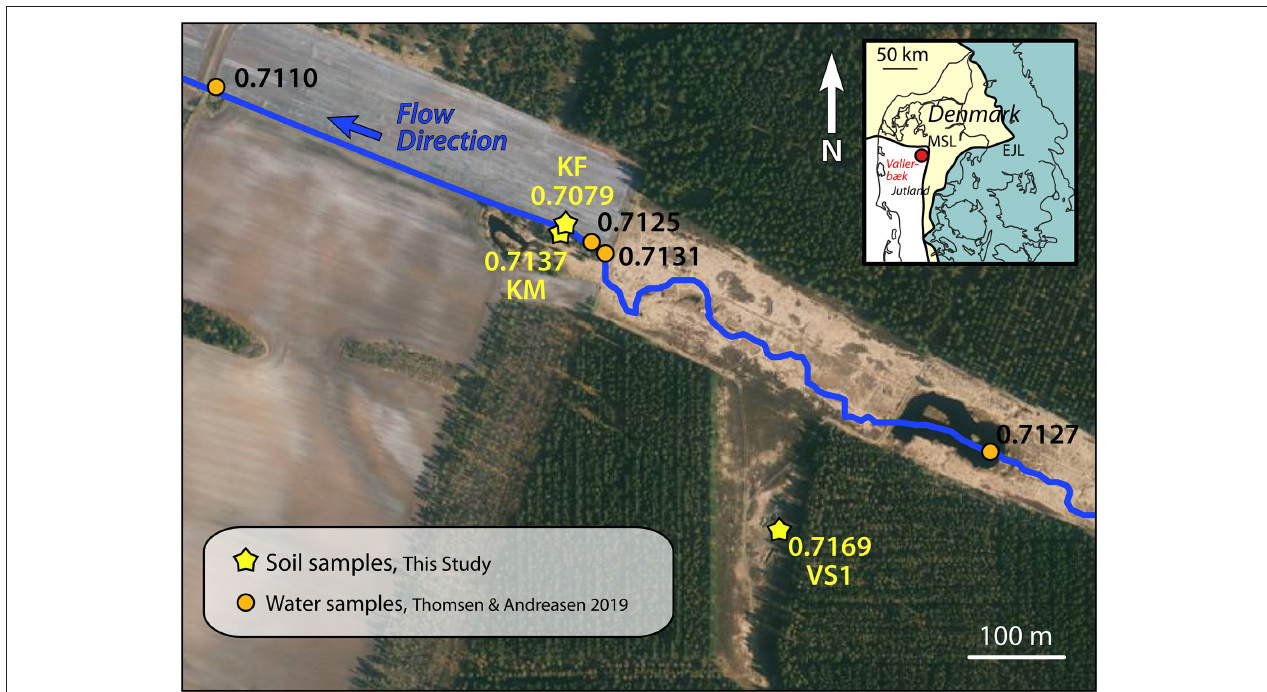
FIGURE 7 | Orthophoto from Spring 2019 of the Vallerbæk tributary of the Karup River, where the stream enters farmland. Measurements of Sr isotopic composition in the stream water (Thomsen and Andreasen, 2019) are shown with orange dots. Measurements of the Sr isotopic composition of ammonium nitrate leachate of soil samples are shown with yellow stars. The flow direction of the stream is SE to NW. The white bands in the fields are varying proportions of quartz in the soil. Map insert shows the locality relative to the two major ice front locations during the Weichselian Ice Age (Houmark-Nielsen, 2003). Orthophoto from Styrelsen for Dataforsyning og Effektivisering